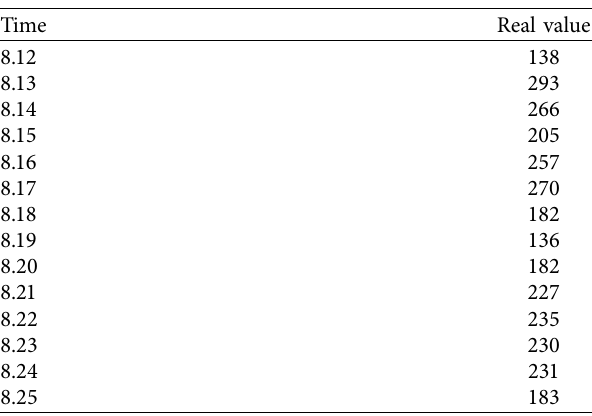
Figure 5: Schematic diagram of the predicted results for stochastic oscillation sequence X Table 2: Trafc fow data veh/h.